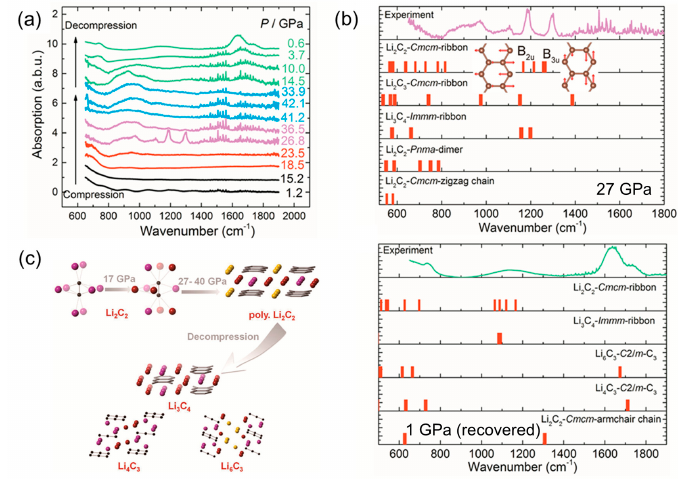
Figure 4. ( a ) In situ IR spectrum of Li 2 C 2 during compression and decompression process [65]. ( b ) Experiment data and theoretical simulations of selected phases at 27 GPa and 1 GPa (recovered) [65]. ( c ) The phase transition and reaction process of Li 2 C 2 under high pressure [65].